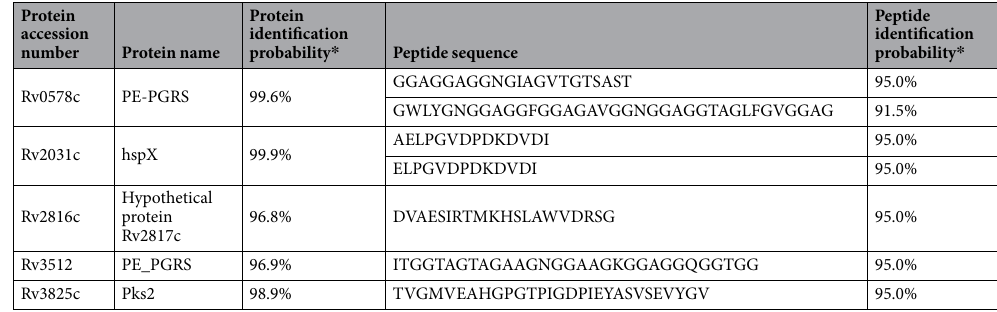
Table 1. Peptides identified from LC-MS analysis of pronase-digested dCW active fraction. * Proteins